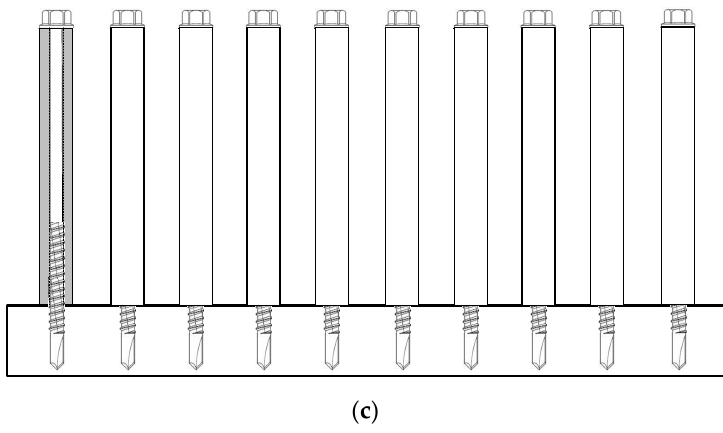
Figure 1. Schematic diagram of ( a ) self ‐ drilling screw, ( b ) sleeve, and ( c ) twist ‐ off strength and HE testing.